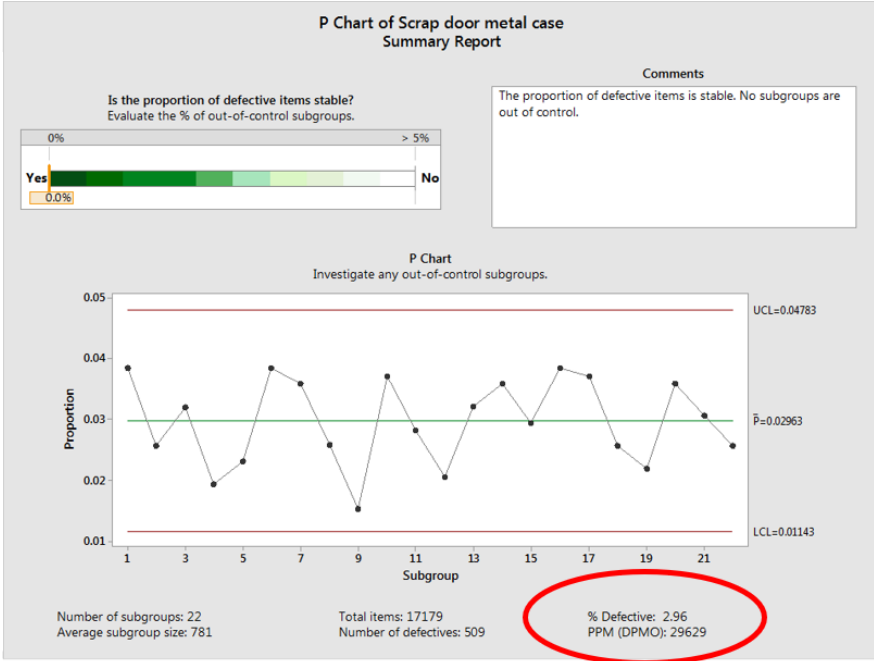
Figure 10. P Chart of scrap metal door case—identification of the number of defaults per million.